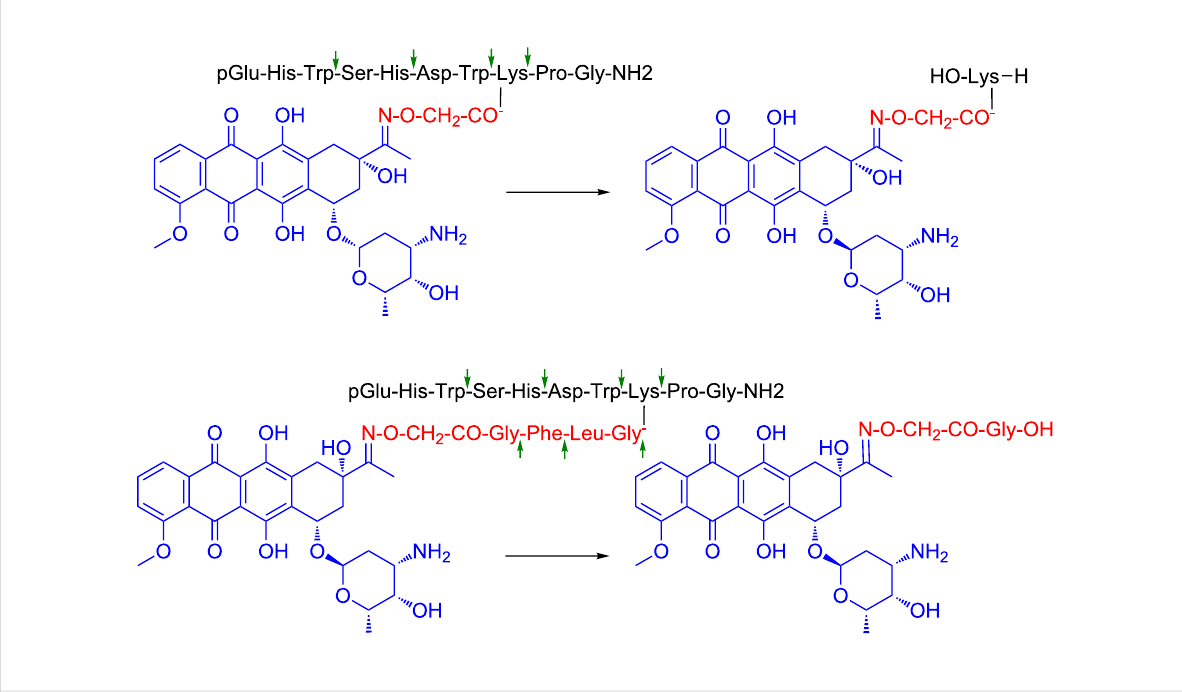
Figure 9: Structure of oxime linked Dau–GnRH-III conjugate with or without cathepsin B labile spacer and their metabolite released in lysosomal homogenate [144].